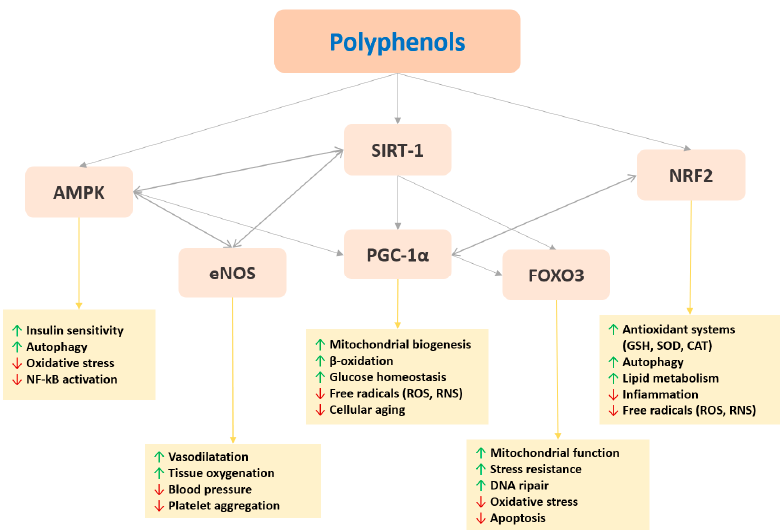
Figure 2. Main transcription factors modulated by polyphenols and related functions on sports performance. For figure description see the text. Legend: AMPK (5’ AMP-activated protein kinase); eNOS (endothelial nitric oxide synthase); SIRT-1 (NAD-dependent deacetylase sirtuin-1); NRF2 (Nuclear factor erythroid 2-related factor 2); PCG-1 α (peroxisome proliferator-activated receptor gamma coactivator 1-alpha); FOXO3 (forkhead box O3); ROS (reactive oxygen species); RNS (reactive nitrogen species). NF-kB (nuclear factor kappa-light-chain-enhancer of activated B cells); GSH (glutathione); SOD (superoxide dismutase); CAT (catalase).